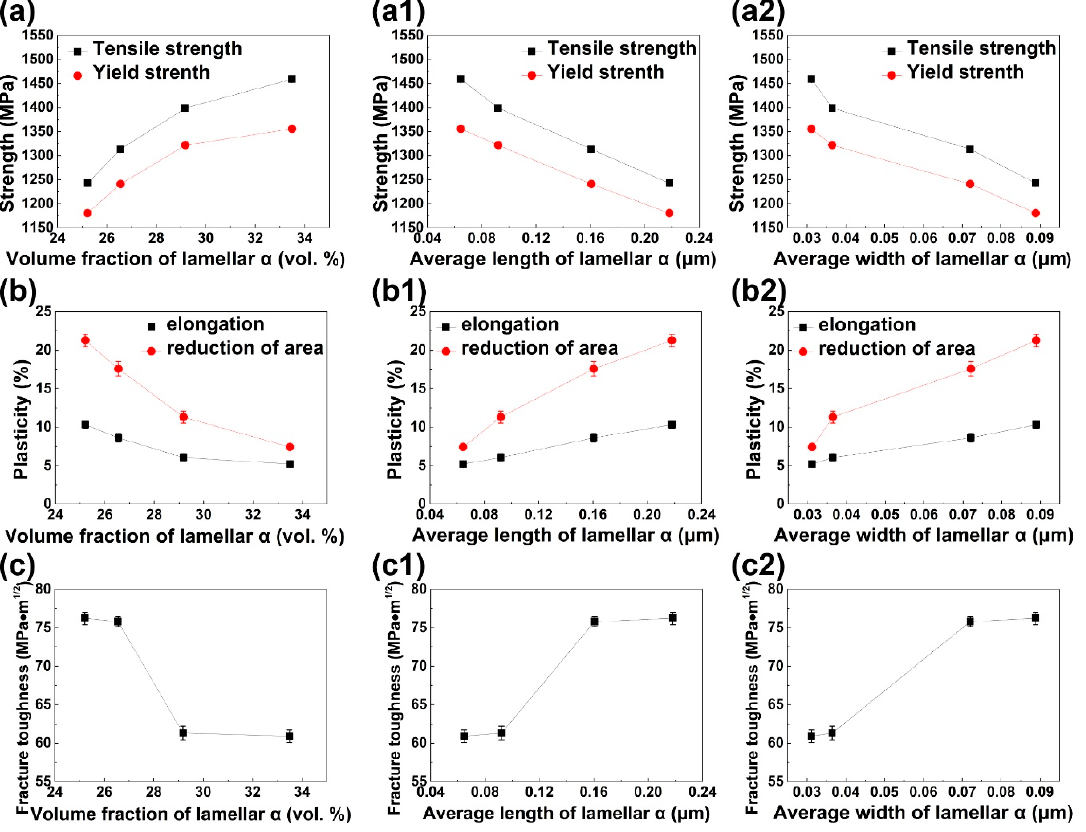
Figure 11. Performance comparison between Ti-35421, Ti-B19, Ti-5553, and Ti-1023: ( a ) yield strength vs. elongation, ( b ) yield strength vs. fracture toughness. (Ti-B19 [29], Ti-5553 [30,31], Ti-1023 [19,32]).